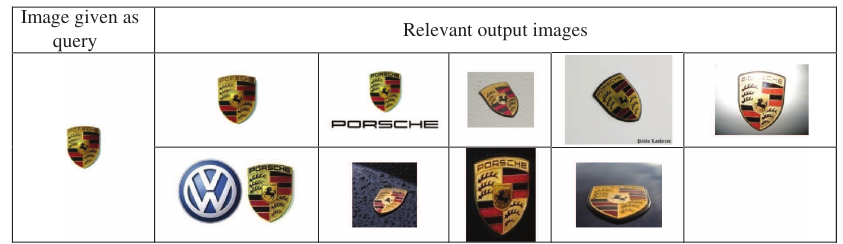
Table 2: Color Similarity-Based Output Retrieved Images.